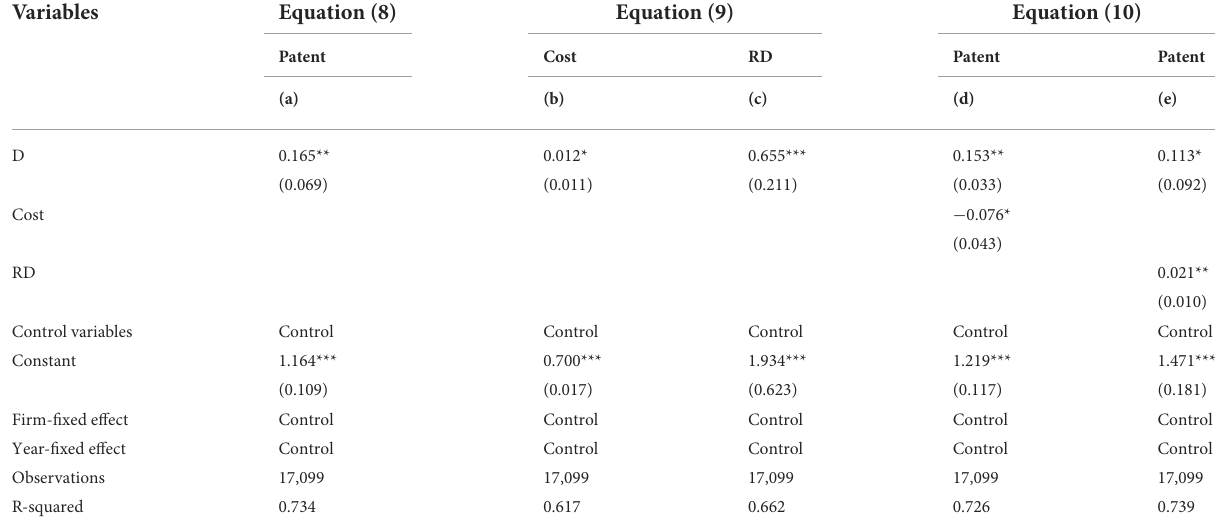
TABLE 10 Results of stepwise regression test of